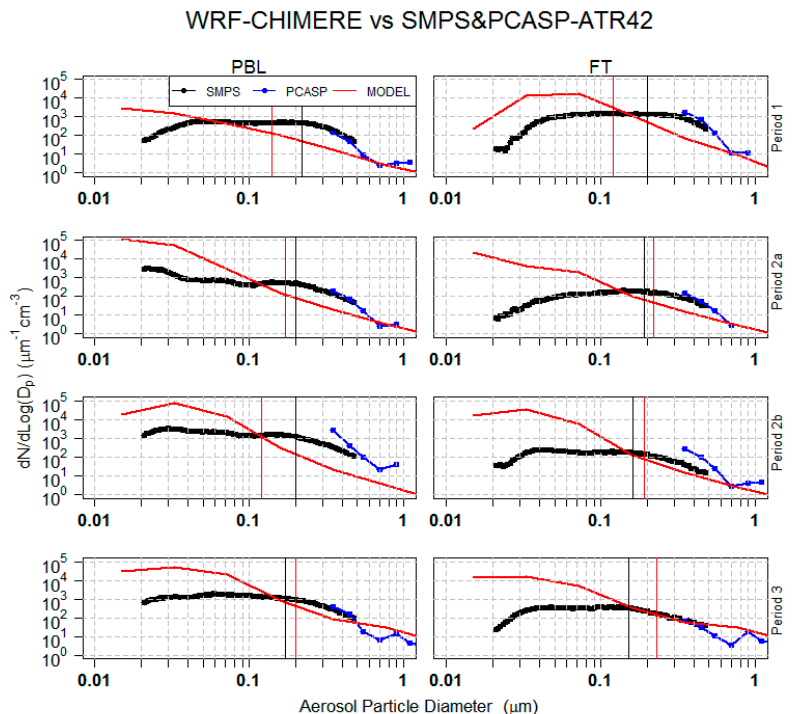
Figure 6. Comparison of measured (SMPS in black, PCASP in blue) and modelled (red) trimean of aerosol size number distribution within the PBL (first column) and FT (second column) along ATR-42 track during the periods 1 (first row), 2a (second row), 2b (third row), and 3 (fourth row). Vertical black and red lines represent the observed and predicted critical diameters for CCN, respectively.